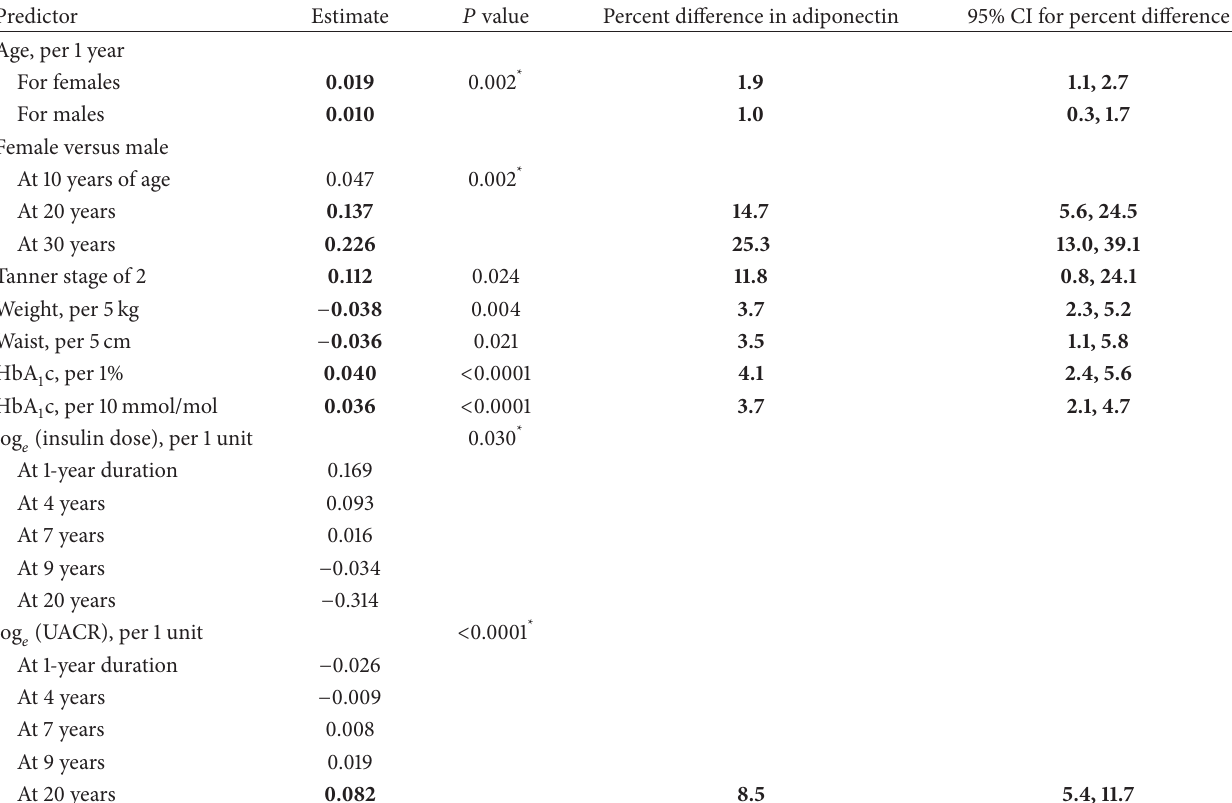
Table 2: Results from the longitudinal model predicting log